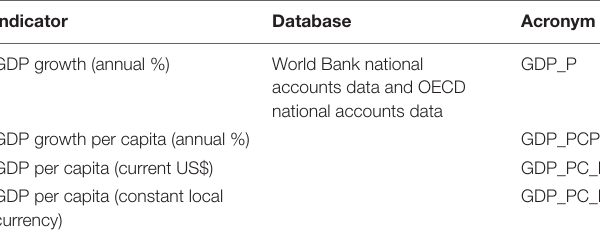
TABLE 4 | Variables corresponding to indicators of secular